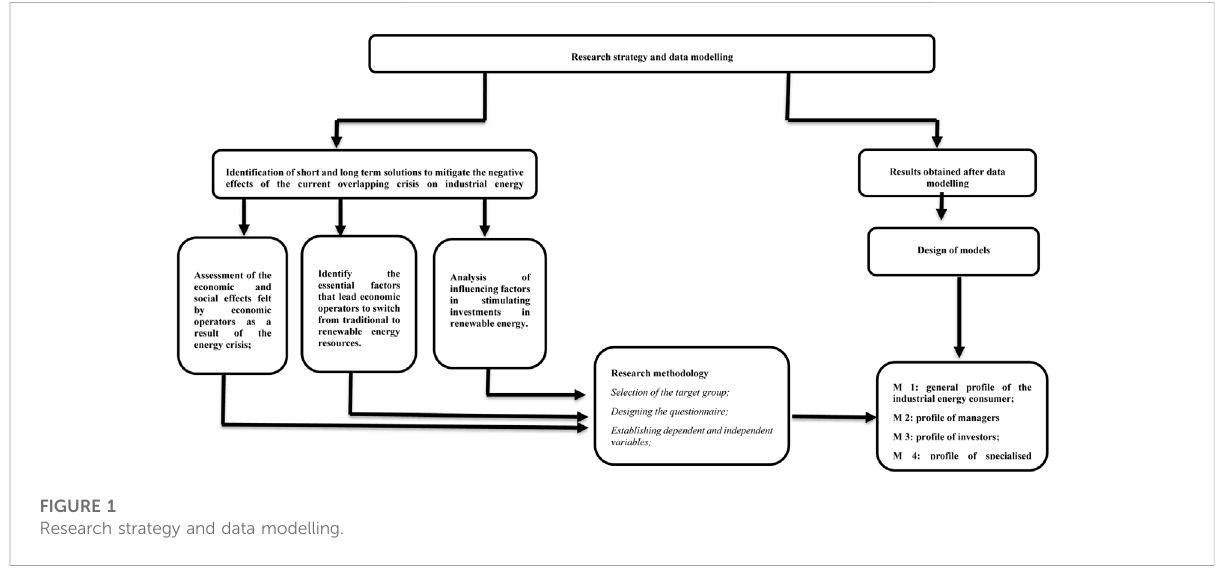
FIGURE 1 Research strategy and data modelling.